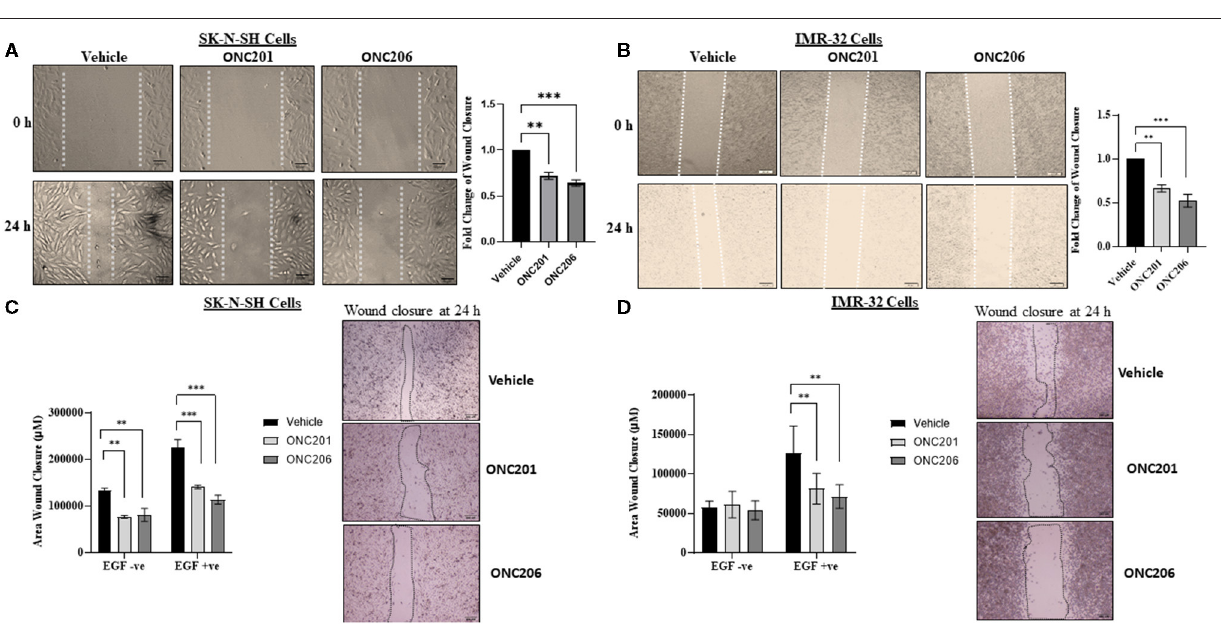
Frontiers in Pediatrics |